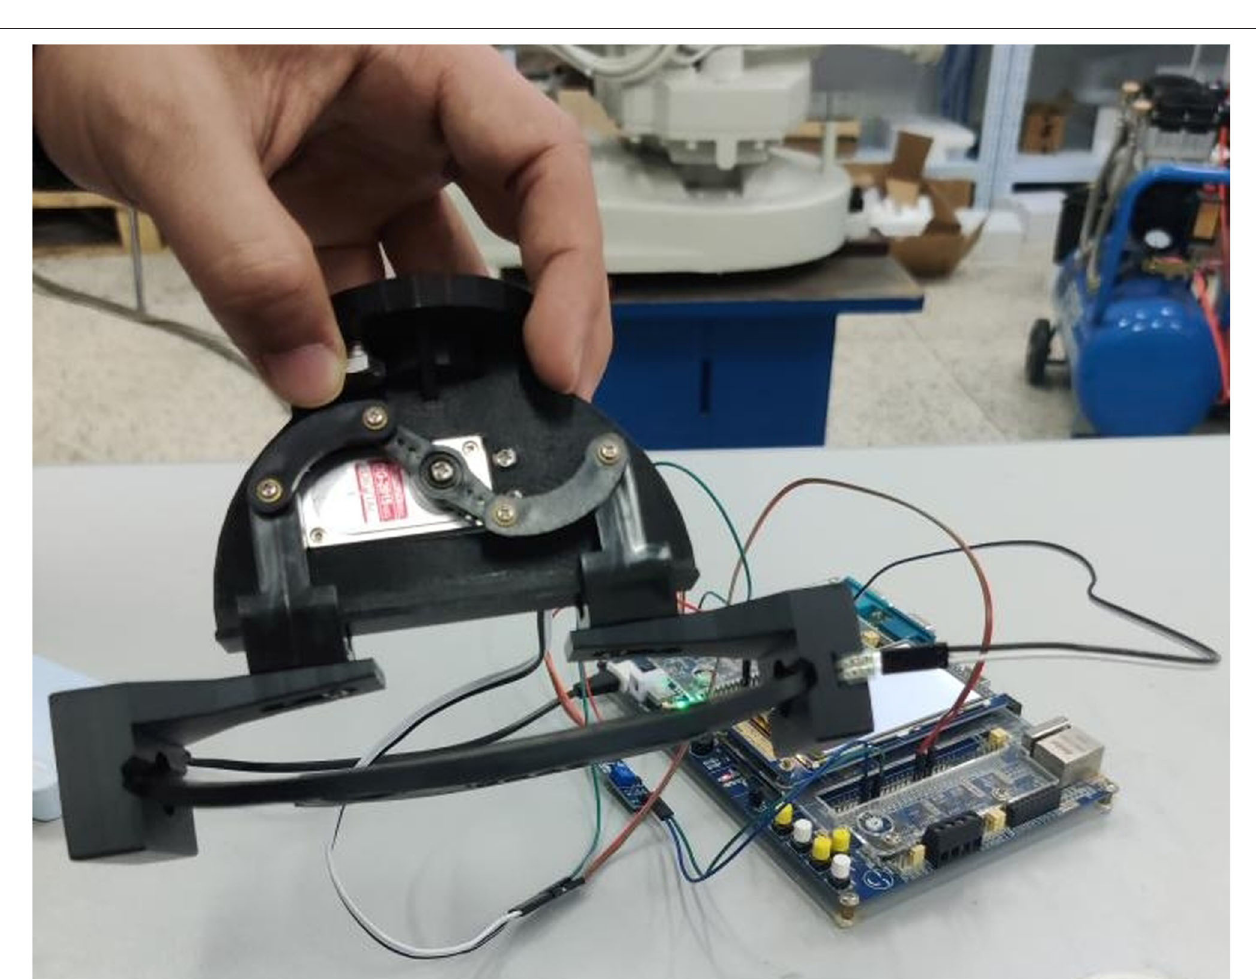
FIGURE 9 | Effect of successfully grasping